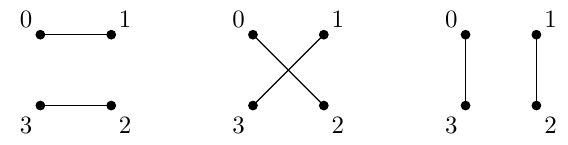
Figure 1: A one-factorisation of the complete graph K